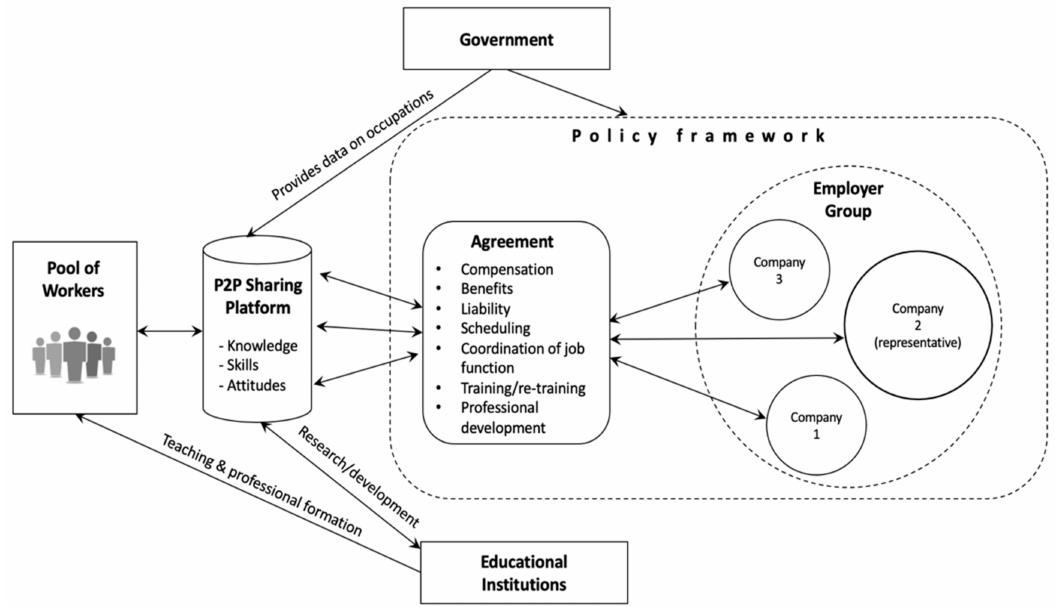
Figure 1. A strategic employee-sharing model